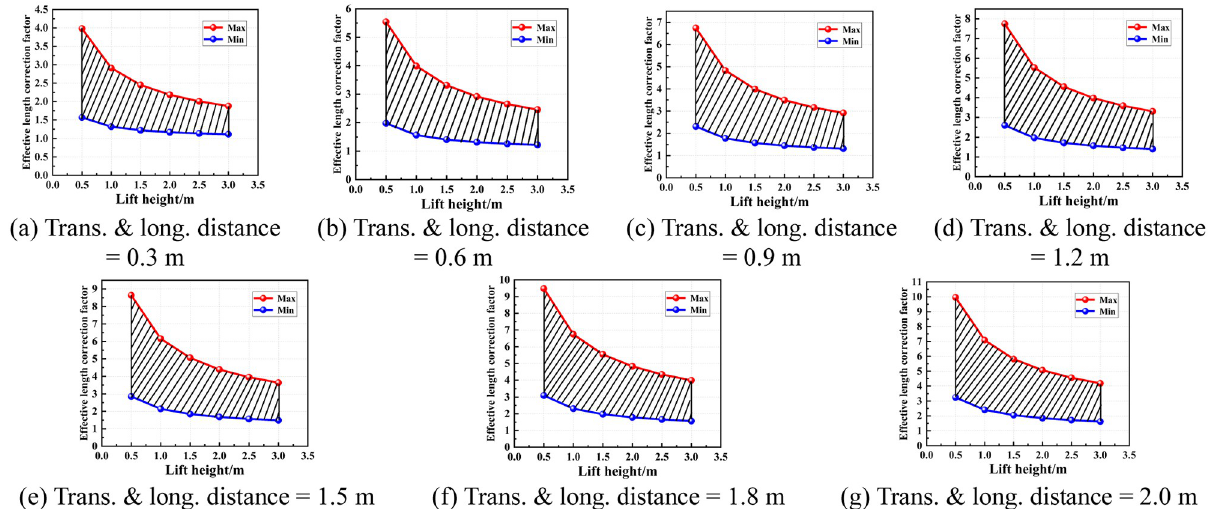
Fig 16. Value areas of the effective length correction factor of condition 1. (a) Trans. & long. distance = 0.3 m. (b) Trans. & long. distance = 0.6 m. (c) Trans. & long. distance = 0.9 m. (d) Trans. & long. distance = 1.2 m. (e) Trans. & long. distance = 1.5 m. (f) Trans. & long. distance = 1.8 m. (g) Trans. & long. distance = 2.0 m.